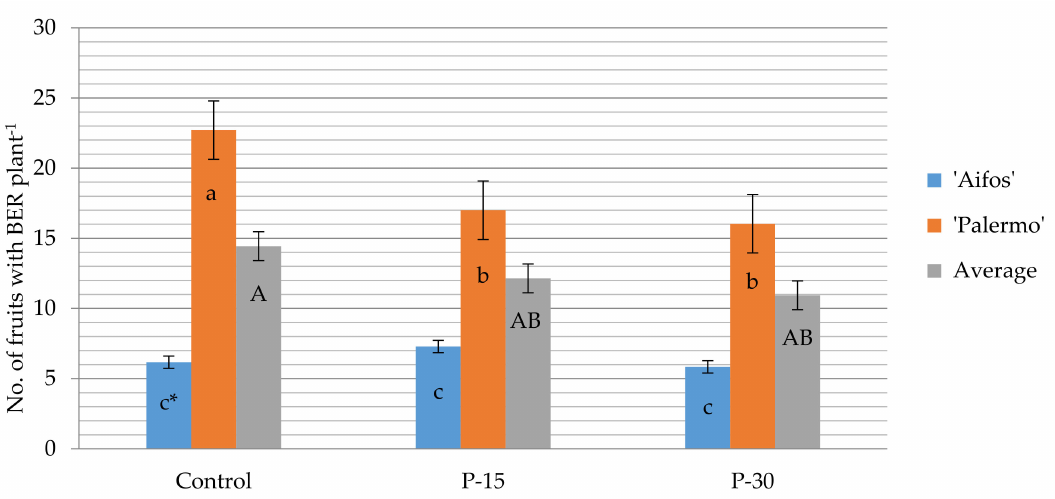
Figure 3. E ff ect of fertilizer with polyphosphates in hydroponic cultivation on the number of BER (blossom end rot) fruit depending on the sweet pepper cultivar. * The bars marked with the same letters do not di ff er significantly according to the Tukey HSD test at α = 0.05.